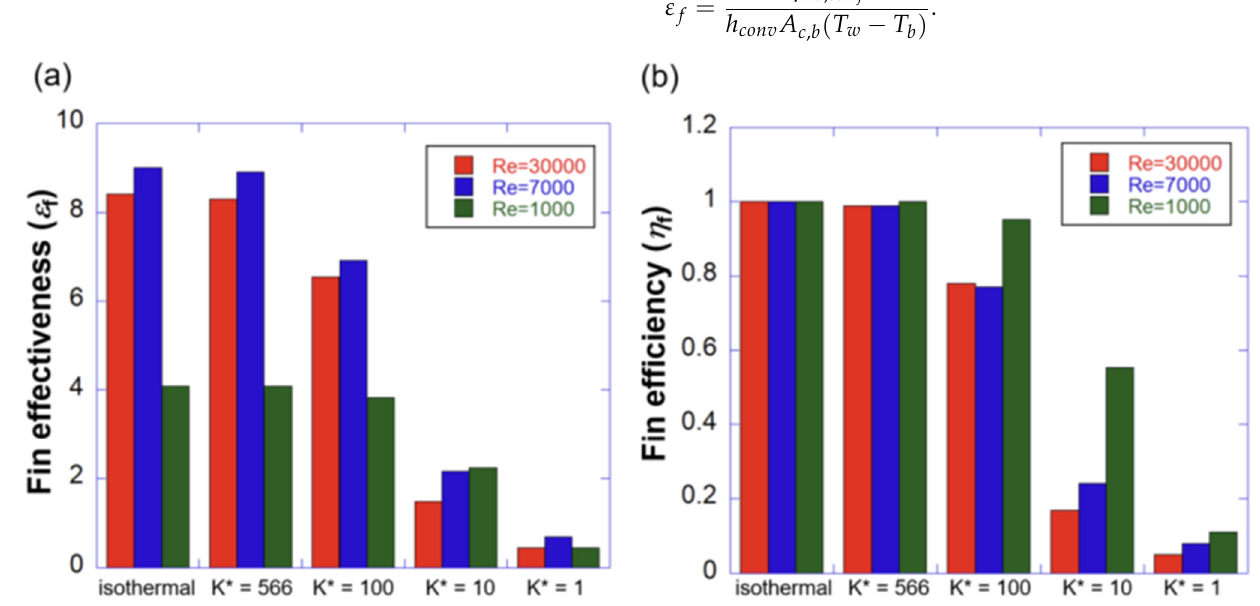
Figure 10. Fin performance of the rib: ( a ) fin effectiveness and ( b ) fin efficiency.